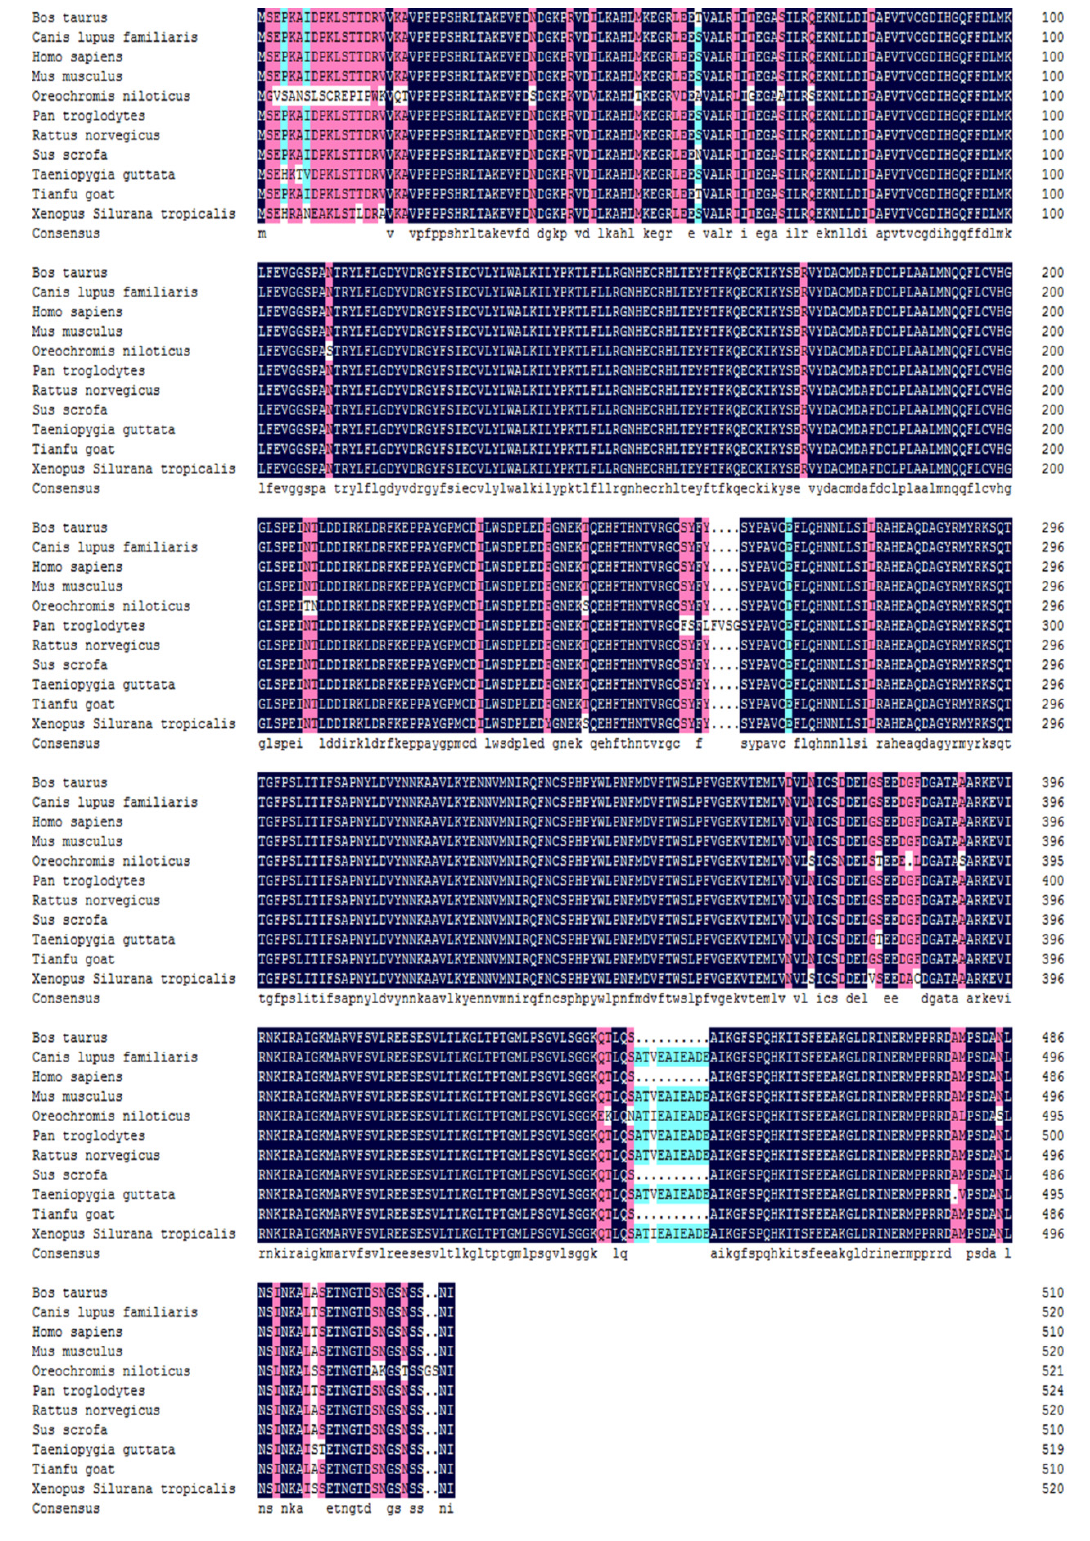
Figure 2. Amino acid sequence alignment of PPP3CA from different species. The blue, pink and blue-green represent the different levels of amino acid sequence similarity of PPP3CA from different species (high, intermediate, and low similarity,